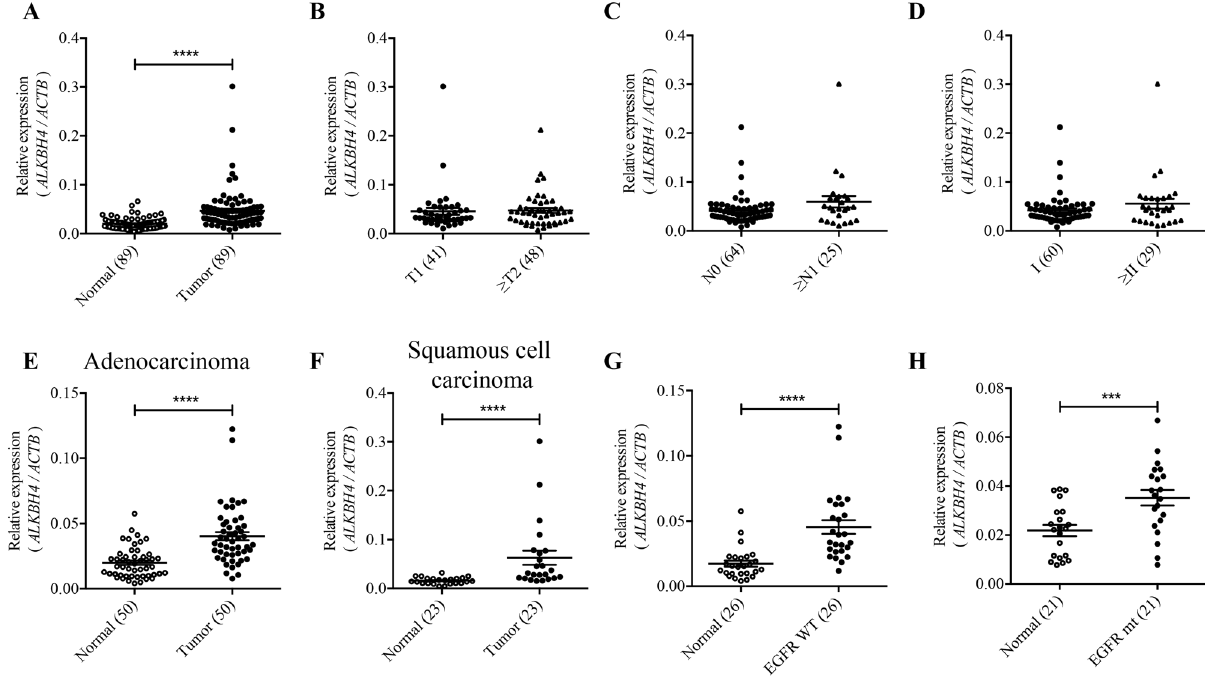
Figure 1. ALKBH4 is highly expressed in NSCLC. ALKBH4 expression levels were measured using qPCR and compared between normal and tumour tissues. ( A ) T classification ( B ), N classification ( C ), stages ( D ), histological types ( E,F ), and EGFR mutation ( WT wild type, mt mutation) status ( G,H ) in NSCLC clinical specimens. Relative ALKBH4 expression normalised to ACTB is shown. Data are represented as mean ± S.D. The number of specimens examined is shown in parentheses. ***p < 0.001; ****p < 0.0001 for paired t -test ( A ) and Student’s t -test ( B – H